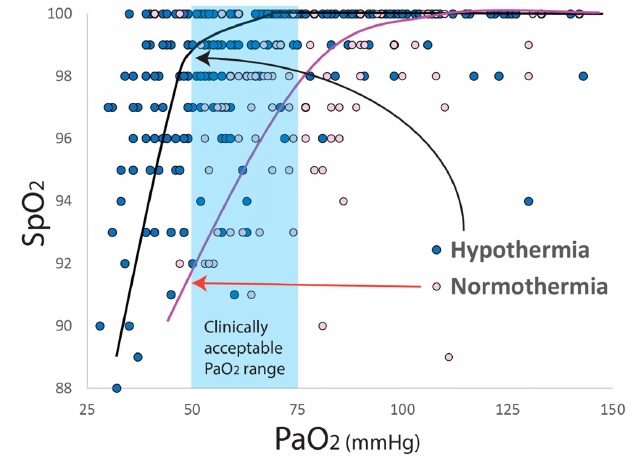
Figure 3. Hemoglobin–oxygen dissociation curve shifts to the left in hypothermia (Afzal et al. 2019). PaO 2 = partial arterial oxygen tension, SpO 2 = oxygen saturation. To achieve the clinically accepted range of PaO 2 50–80 mmHg, SpO 2 target is in the low-to-mid 90s during normothermia but in the high 90s during whole body hypothermia. Copyright Satyan Lakshminrusimha.